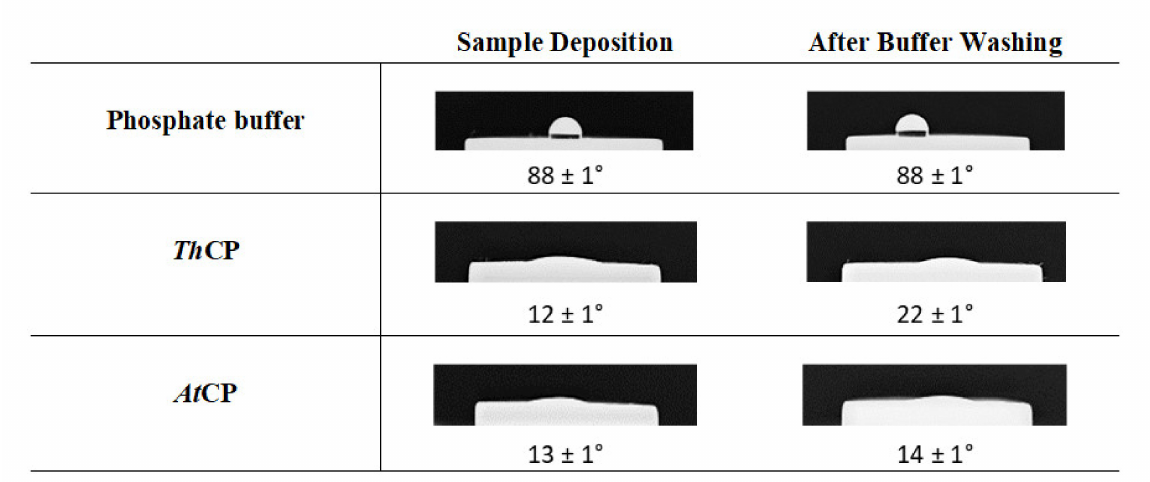
Figure 6. Water Contact Angle (WCA) analysis of hydrophobic surface (PTFE) upon deposition of CPs, before and after washing with 10 mM Phosphate bu ff